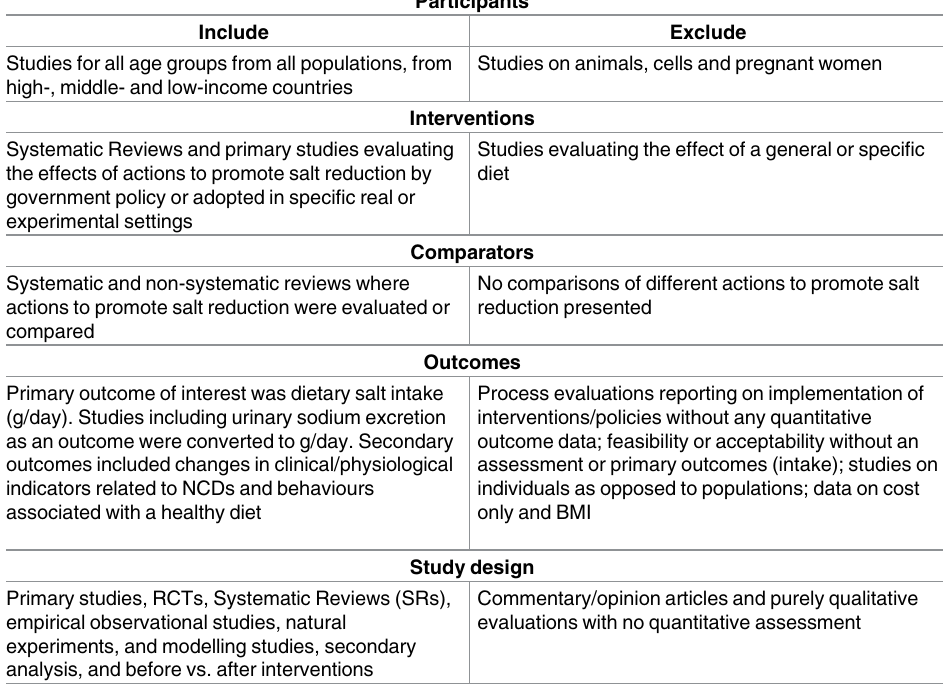
Table 1. PICOS; Inclusion/exclusion